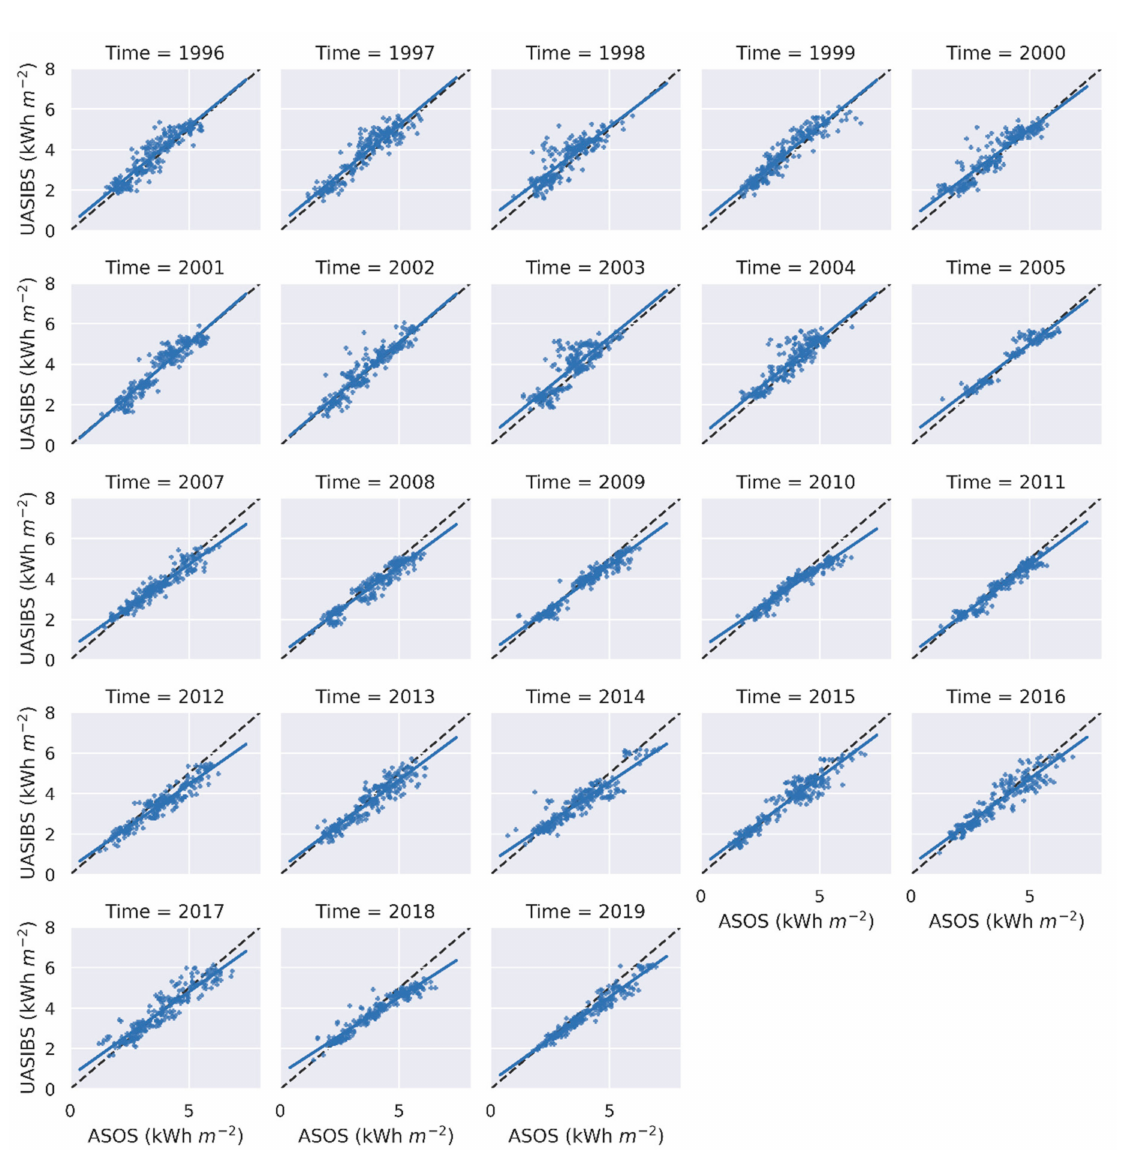
Figure 6. Same as Figure 2, but distributed for every year. The monthly variation in error statistics is substantially related to the Korean monsoon, i.e., the East Asian monsoon. In spring and fall seasons, the sky is usually clear; however, heavy precipitation events occur in the summer, due to the strong front system [51–53]. The rMAE values were relatively low in the spring and fall seasons. However, the UASIBS– KIER model failed to estimate the GHI in the right direction in June and July. Furthermore, the behavior of rMBE is strictly distinguished by season; it is almost negative from January to June, but positive from July to December. Therefore, the derivation model overestimated the COD in the warming season, whereas the opposite was true in the cooling